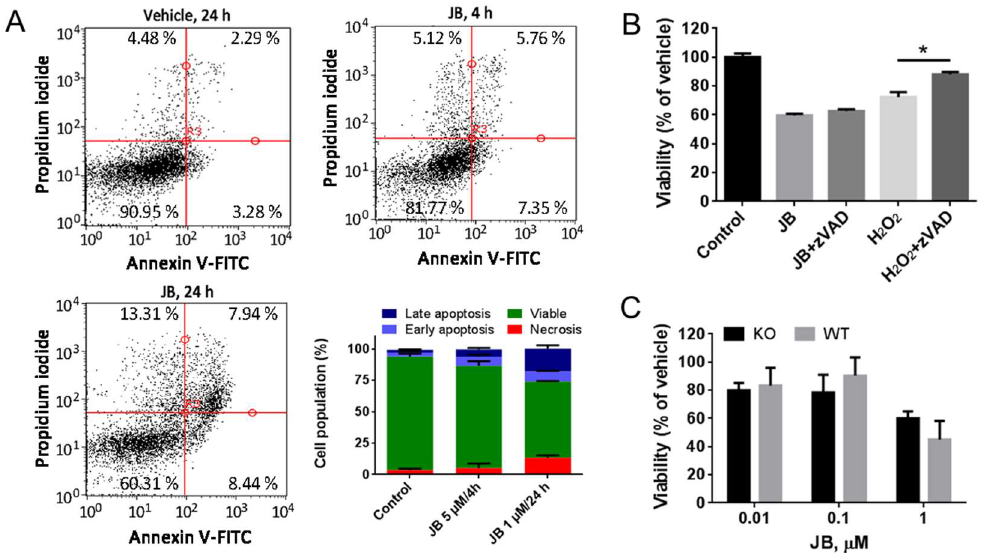
Figure 2. Analysis of apoptosis induced by Jaspine B (JB) in A549 cells. ( A ) A549 cells were incubated with 0.05% EtOH for 24 h (control), 5 µM JB for 4 h or 1 µM JB for 24 h and then stained with annexin V (AV)/propidium iodide (PI). Fluorescence was analyzed by flow cytometry. Data were obtained from 2 experiments in triplicate. ( B ) Determination of cell viability by MTT assay in A549 cells treated for 24 h with 1 µM JB in the presence or absence of 100 µM carbobenzoxy-valyl-alanyl-aspartyl-[O-methyl]-fluoromethylketone (z-VAD) or 10 µM H 2 O 2 in the presence or absence of 100 µM z-VAD. Results are the mean ± SD for two experiments performed in triplicate and are expressed as the percentage of the viability compared to the control. * p < 0.005. ( C ) Determination of cell viability by MTT assay of mouse embryonic fibroblasts (MEF) double knockouts (Bax/Bak KO) for Bcl-2-associated X protein (Bax) and Bcl-2-antagonist/killer 1 (Bak) and MEF wild-type (Bax/Bak WT) incubated with different concentrations of JB for 24 h. Results are the mean ± SD of two experiments in triplicate.